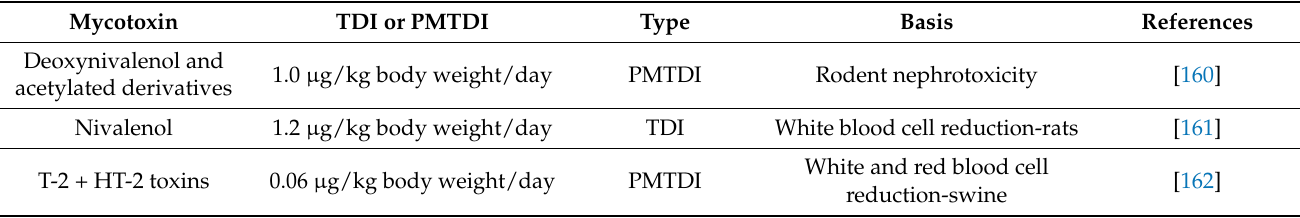
Table 4. Recommended maximum tolerable daily intake for major TCT mycotoxins.